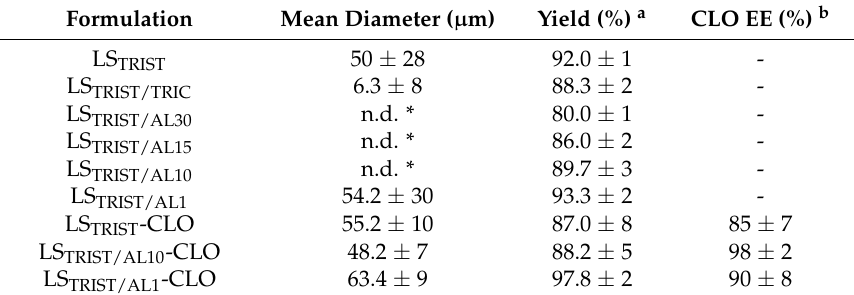
Table 3. Liposphere mean diameter, yield, and clotrimazole encapsulation